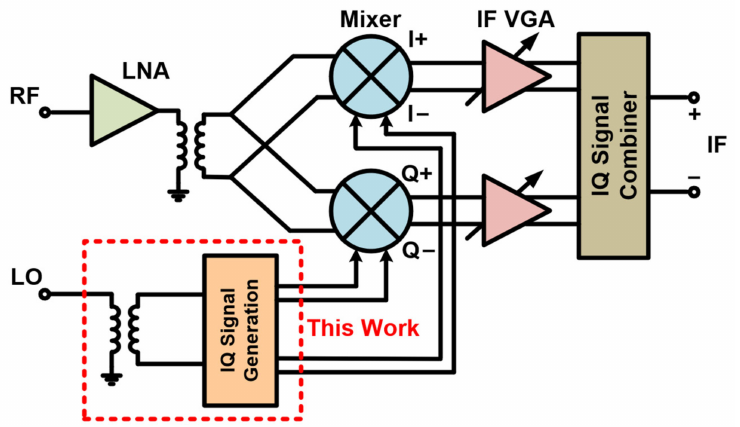
Figure 1. Wideband 5G receiver with quadrature signal generation and